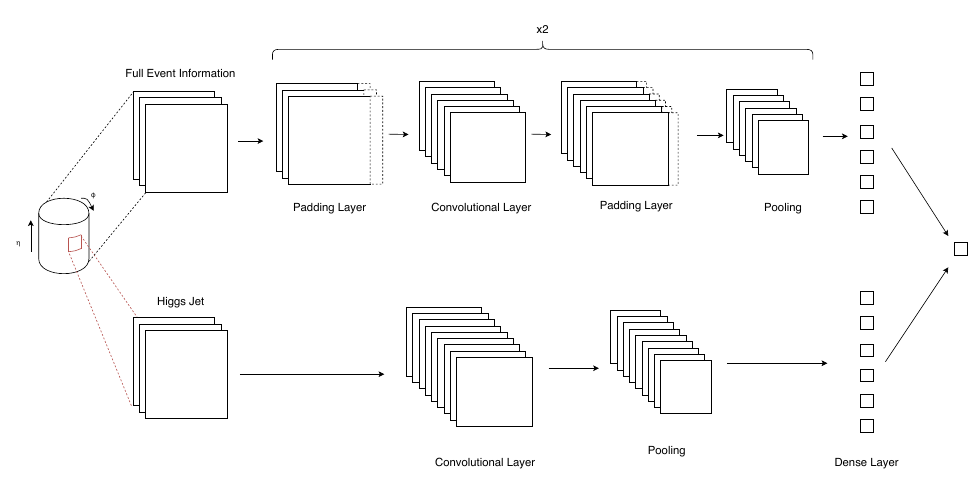
Figure 1 . A schematic of the two-stream CNN used in this study. The (cid:12)rst stream uses the full event information, while the second stream uses the jet substructure information. More details on the architecture are provided in the